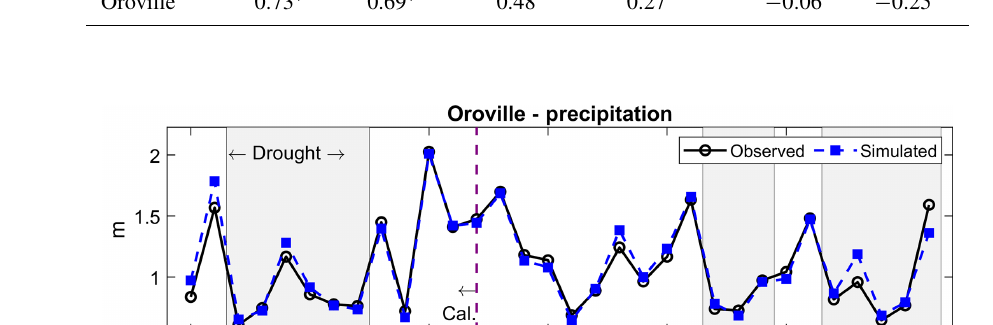
Hydrol. Earth Syst. Sci., 24, 4317–4337,